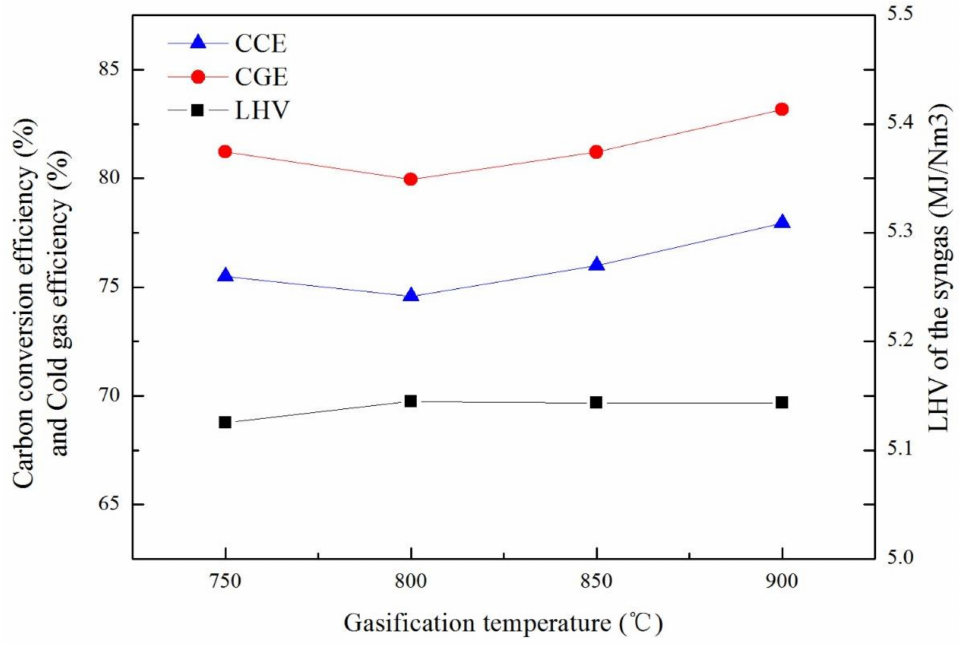
Figure 6. CCE, CGE, and LHV values in